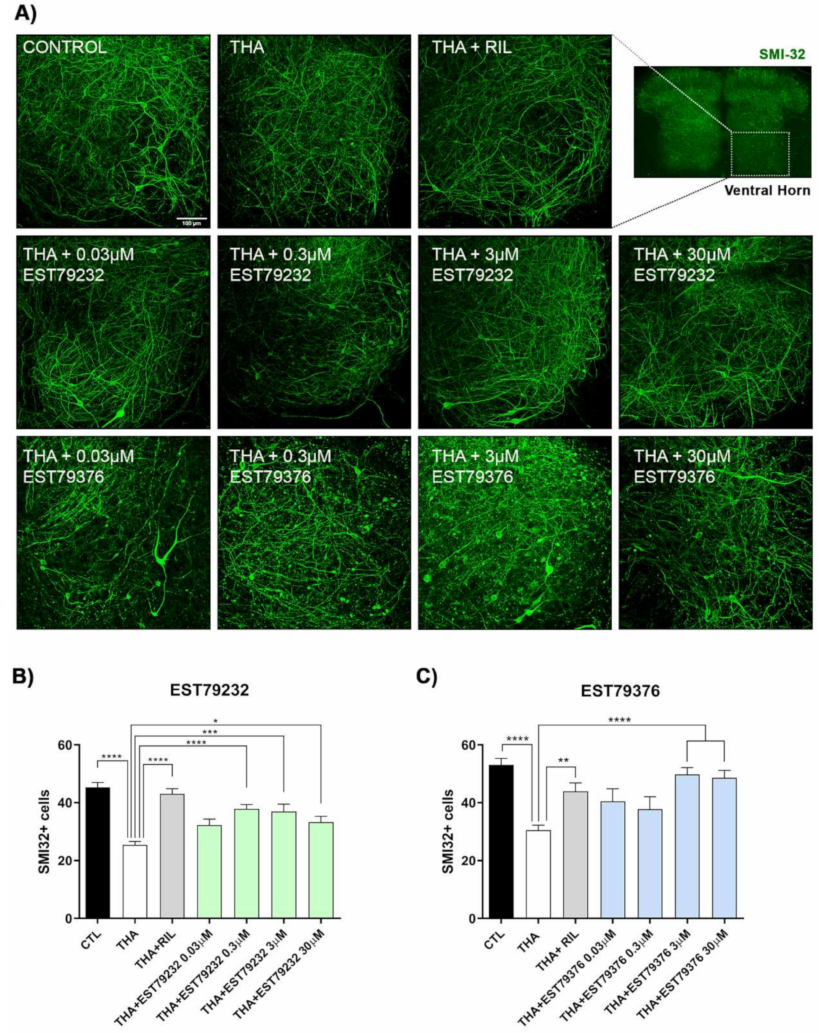
Figure 2. EST79232 and EST79376 ligands prevent MN death under chronic excitotoxicity. ( A ) Representative confocal images of spinal cord ventral horns labeled with SMI32 antibody at 28 DIV for control, THA and THA plus EST79232 or EST79376 treated at four concentrations (0.03, 0.3, 3, and 30 µ M). Scale bar: 100 µ m. ( B , C ) Bar graphs showing the number (mean ± SEM; n = 20–24 hemisections per treatment) of SMI-32-positive cells of each spinal cord hemislice. One-way ANOVA, followed by Bonferroni’s post-hoc test; **** p < 0.0001, *** p < 0.001; ** p < 0.01, * p < 0.05 vs. THA condition. Table 1. Plasma levels of EST79232, EST79376, and PRE-084 after chronic intraperitoneal administration.